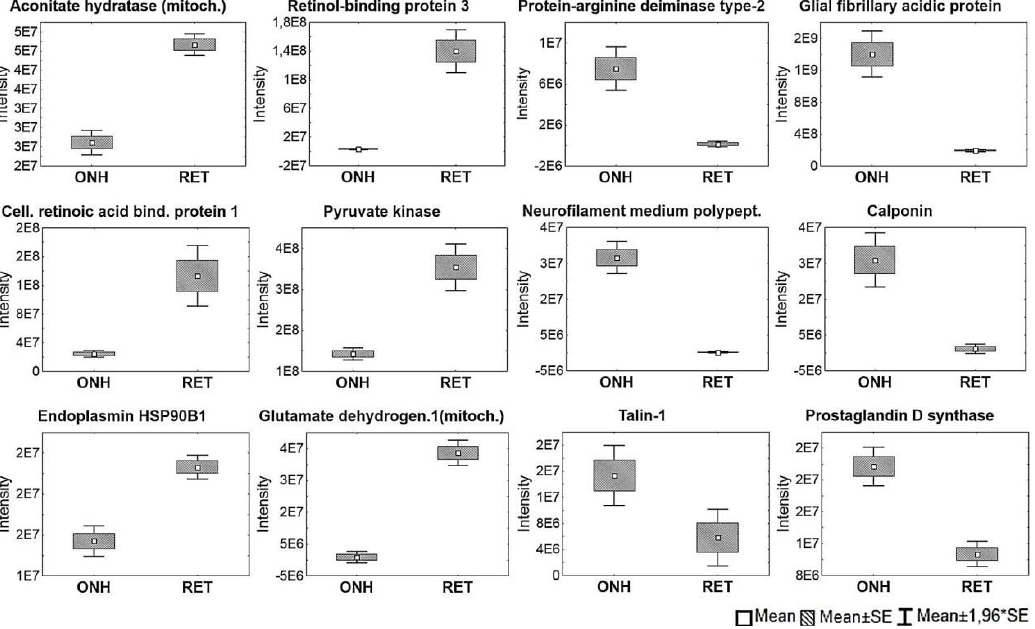
Figure 5. Exemplary candidate proteins characteristic for ONH or RET tissue. The illustrated label-free quantification (LFQ) protein abundance differences ( p < 0.05) were based on BULCMS analysis followed by MaxQuant LFQ determination.